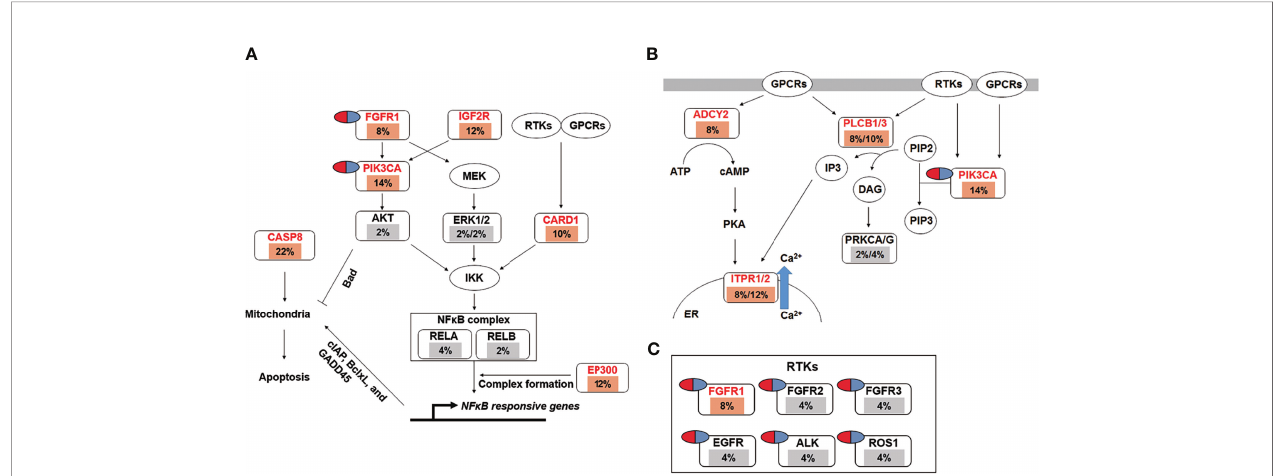
FIGURE 7 | The landscape of major altered genes and signi fi cantly altered pathways in OSCC. The NF k B signaling (A) and calcium signaling pathways (B) were identi fi ed by IPA canonical pathway analysis. Pill illustrations show FDA approved drugs which are targeting receptor tyrosine kinase families and PIK3CA . Genes were assigned to each pathway and represented with their mutation frequencies (orange font: top 200 frequently mutated genes [ ≥ 8%] which were imported into the IPA analysis; gray font: genes with <8% mutation frequencies which were not included in IPA analysis).